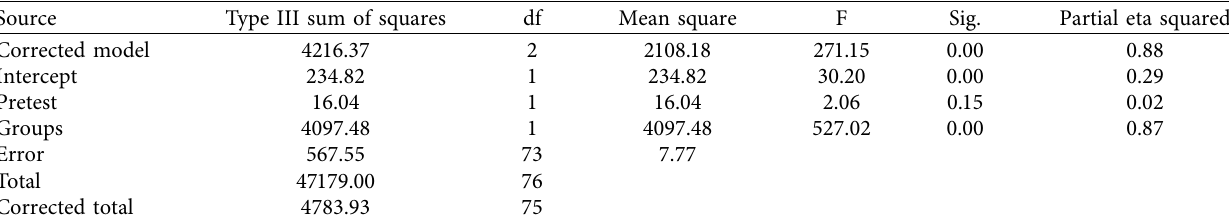
Table 5: Results of one-way ANCOVA (posttest of EG and CG).